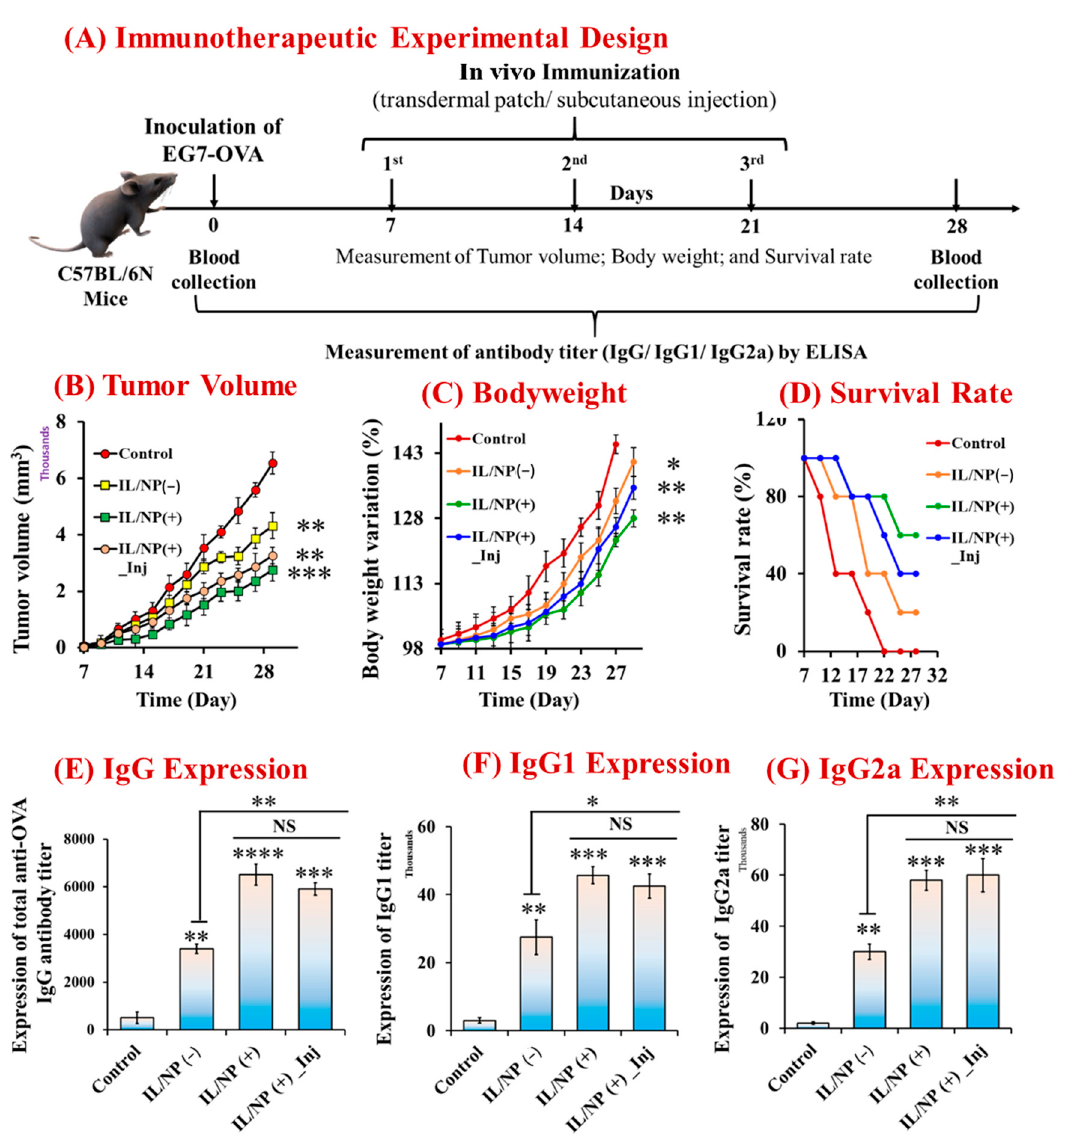
Figure 5. Antitumor e ff ects of the protein- and immunomodulator-containing IL-associated nanovaccine. ( A ) Schematic illustration of the therapeutic experiment. ( B ) E ff ects on tumor growth and